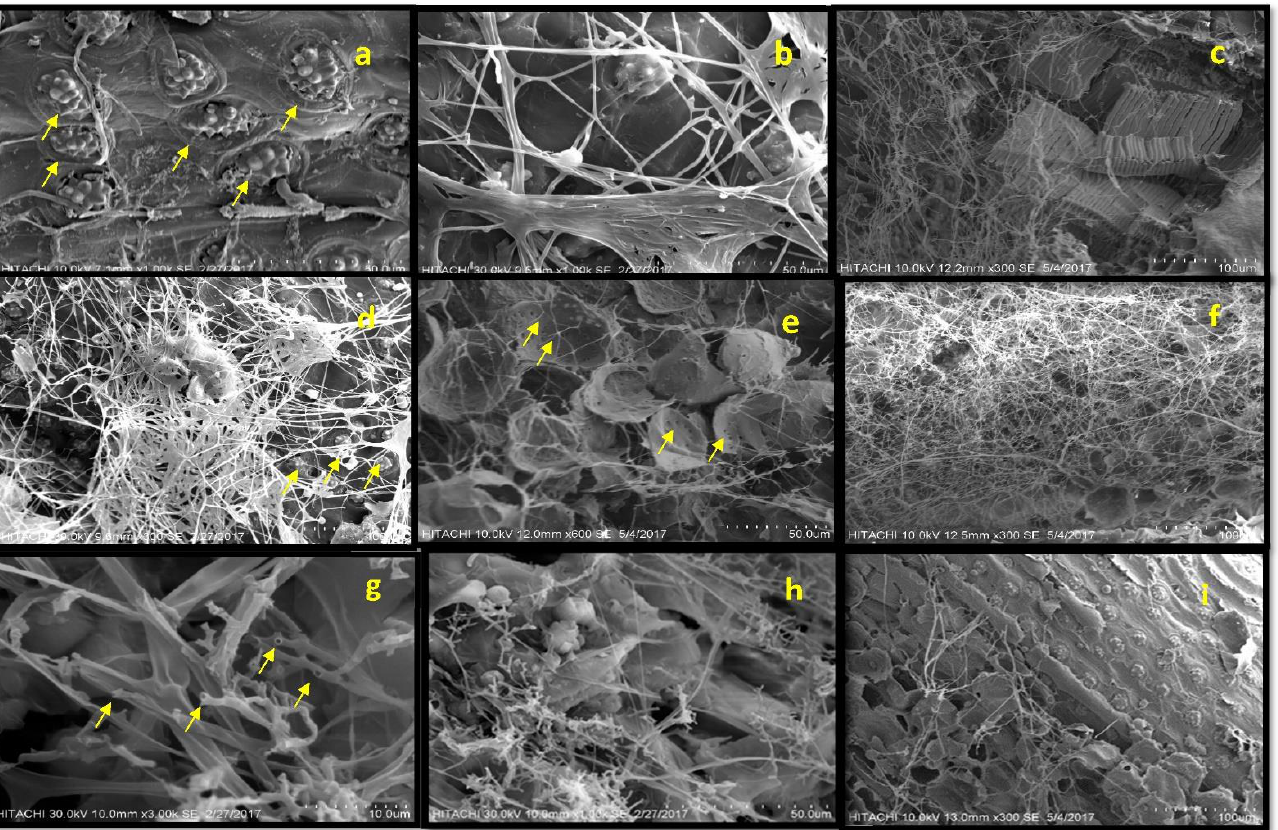
Figure 2. Scanning electron microscope (SEM) analysis of healthy and infected oil palm wood sample subjected to various treatments. ( a ) Intact silica bodies in healthy oil palm wood; ( b ) the initial stage of apical colonization of G. boninense in oil palm wood; ( c ) the control wood samples with silica bodies on the surface of oil palm woodblocks were completely dissociated, and show extensive deterioration in the wood cell walls; ( d ) dense hyphae on oil palm wood treated with 1 mM vanillic acid; ( e ) woodblocks treated with 1 mM syringic acid at 30th day; ( f ) colonization of G. boninense on woodblocks treated with 1 mM vanillic acid at the120th day; ( g ) a closer look at the hyphae with clefts grown on woodblocks treated with 5 mM salicylic acid; ( h ) G. boninense with deformities on woodblocks treated with 1 mM salicylic acid; ( i ) intact silica bodies on the oil palm woodblocks treated with 1 mM benzoic acid at the 120th day.